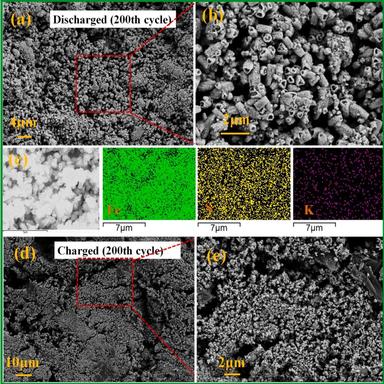
(a, b) Ex-situ FE-SEM images of the Fe3S4 (150 °C) electrode in the discharged state after 200th cycles at different magnifications; (c) EDS images of the Fe3S4 (150 °C) electrode in the discharged state after the 200th cycles. (d, e) FE-SEM images of the Fe3S4 (150 °C) electrode in the charged state after 200th cycles at different magnifications;.